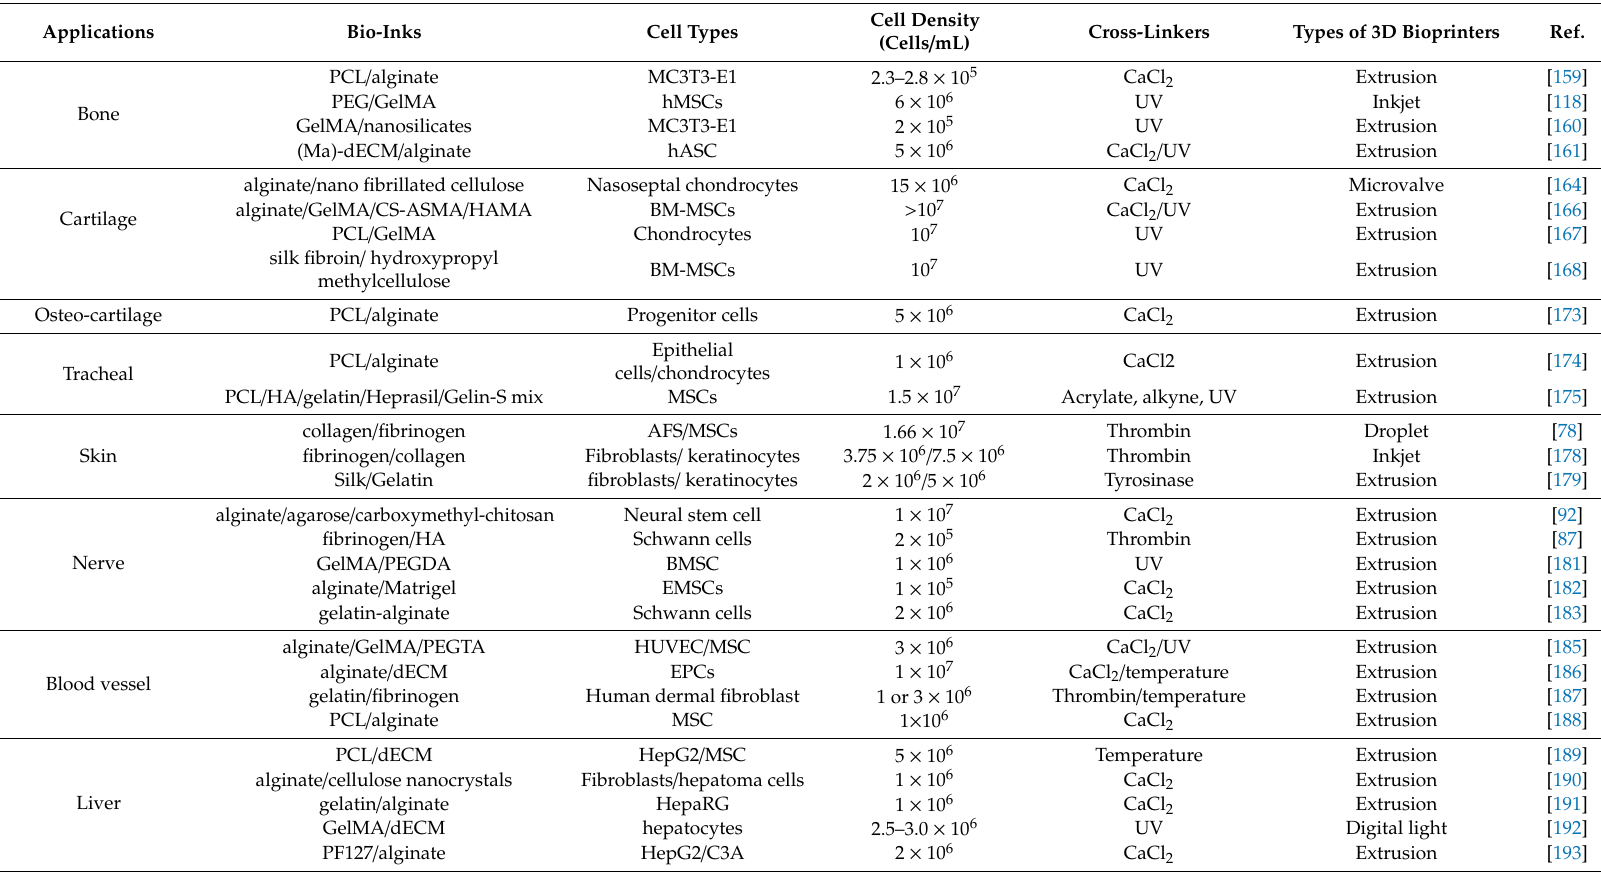
Table 2. Recent works on composite bio-inks related to 3D